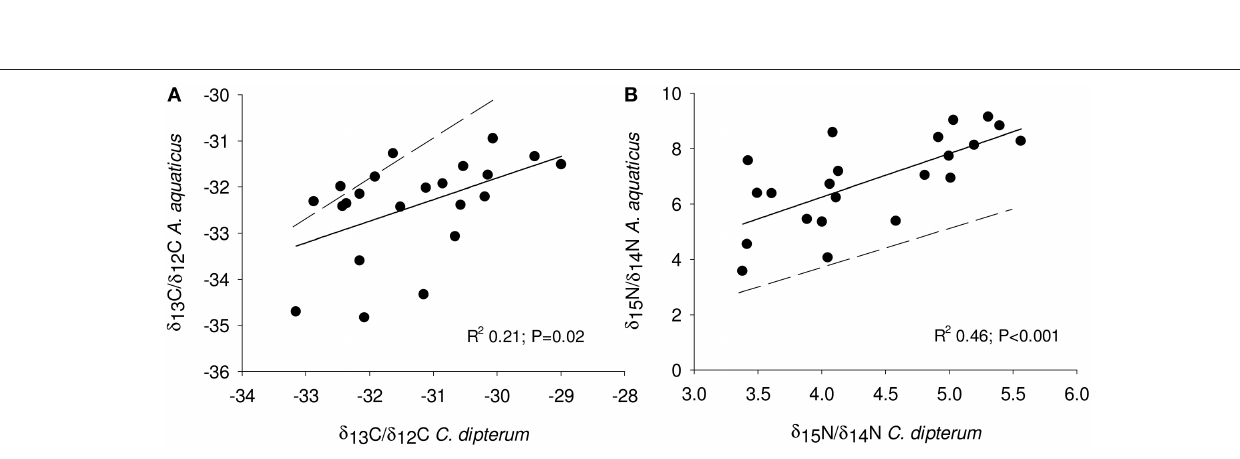
Frontiers in Environmental Science |